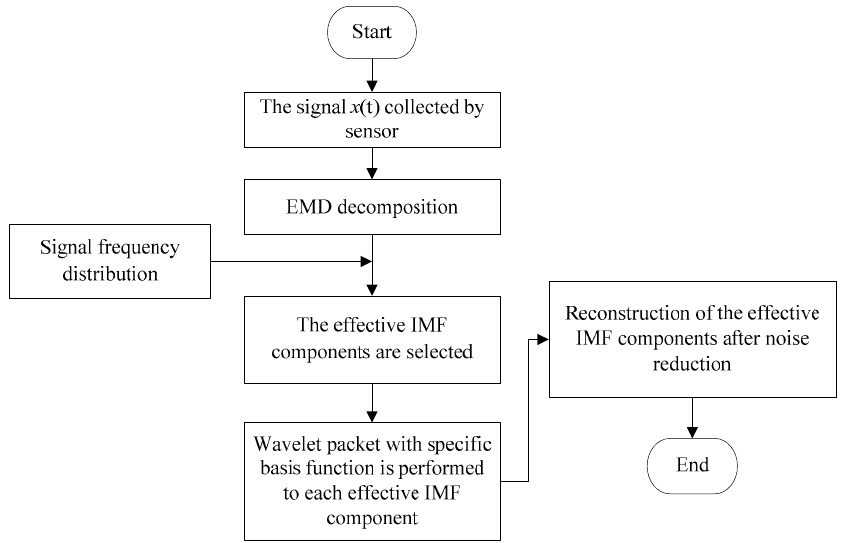
Figure 2. The flow chart of the noise reduction method based on EMD and wavelet packet.